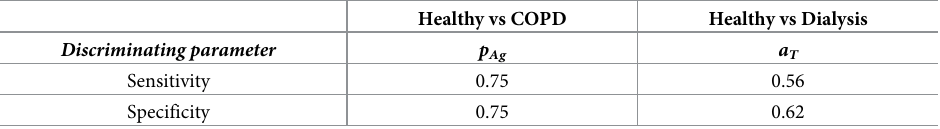
Table 3. Sensitivity and specificity of the proposed test using the most discriminative parameters to identify dis- eased patients compared to healthy